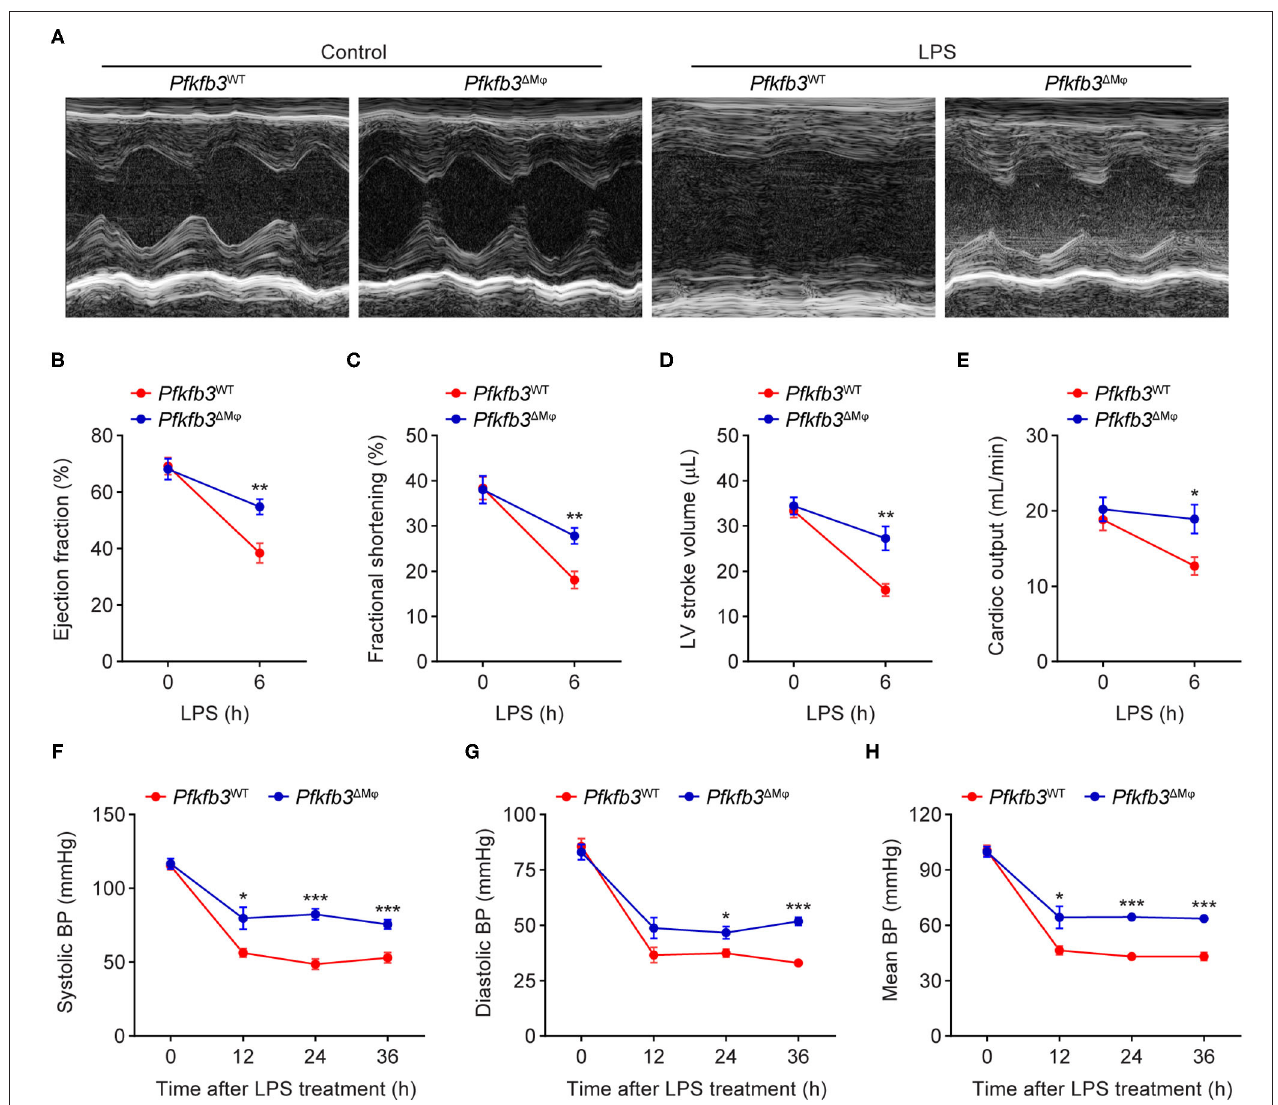
FIGURE 3 | Myeloid-specific Pfkfb3 deficiency protects mice from LPS-induced cardiac dysfunction. (A) Representative M-mode echocardiograms of Pfkfb3 WT mice and Pfkfb3 1 M φ mice 6h after LPS injection. (B-E) Quantification of ejection fraction (B) , fractional shortening (C) , left ventricle stroke volume (D) , and cardiac output (E) of Pfkfb3 WT mice and Pfkfb3 1 M φ mice 6h after LPS injection ( n = 5). (F–H) Systolic blood pressure (F) , diastolic blood pressure (G) , and mean blood pressure (H) of Pfkfb3 WT mice and Pfkfb3 1 M φ mice before and after LPS injection ( n = 8). All data are represented as mean ± SEM, * P < 0.05, ** P < 0.01 and *** P < 0.001 for Pfkfb3 WT vs. Pfkfb3 1 M φ (unpaired two-tailed Student’s t